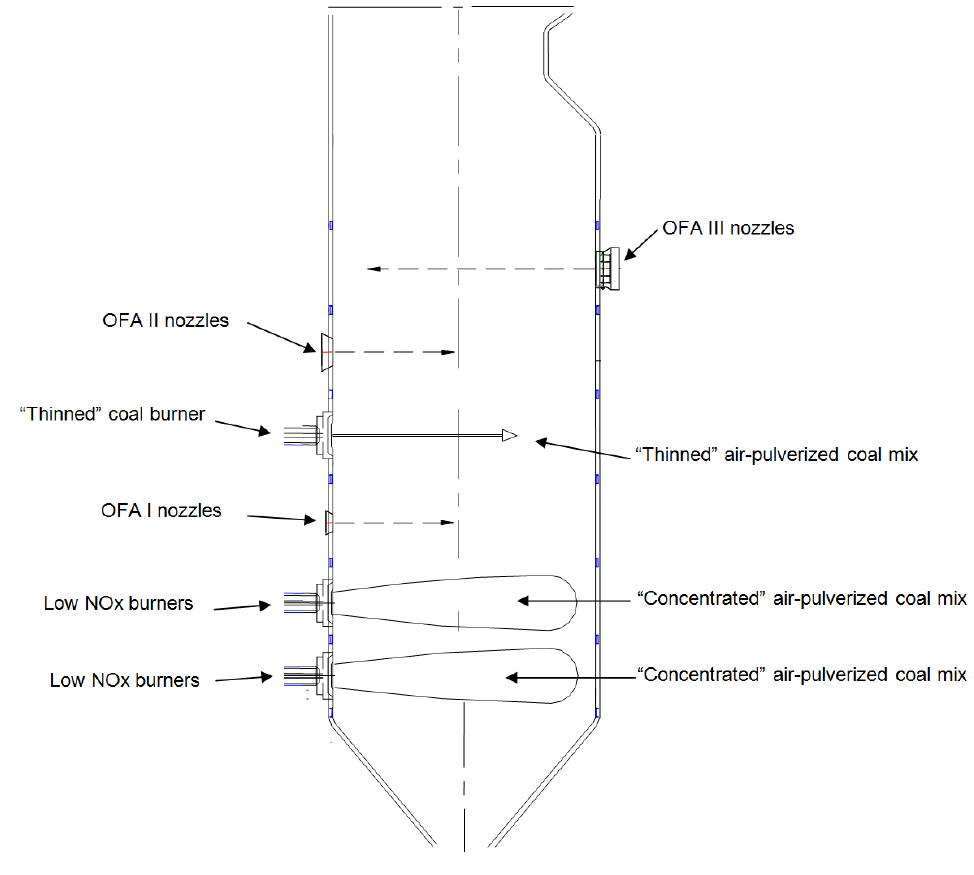
Figure 3. Combustion system in the OP 650 boiler.